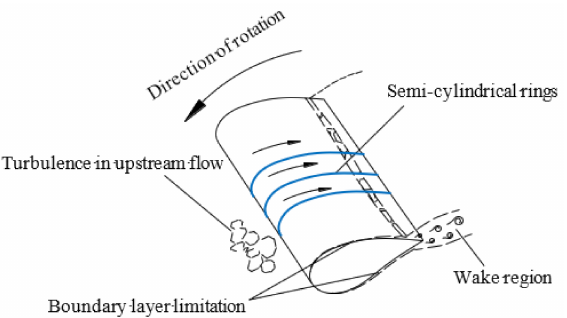
Figure 2. Schematic diagram of the proposed biomimetic technique.